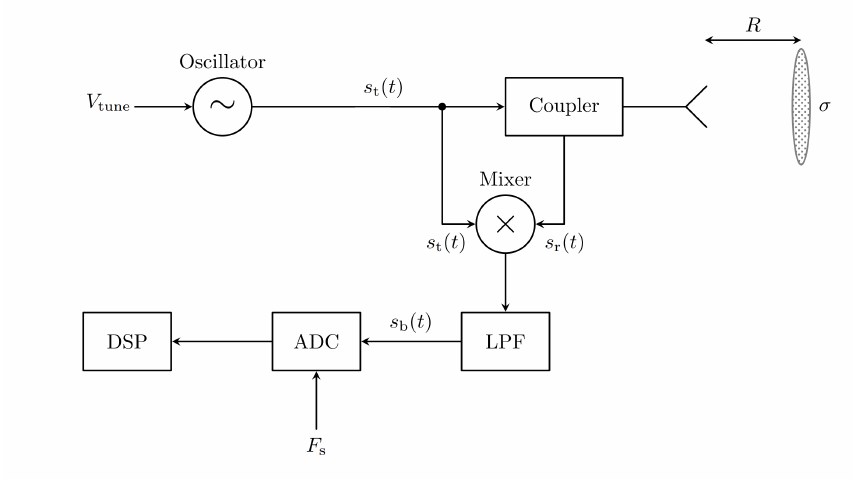
Figure 1. FMCW radar block diagram [23].